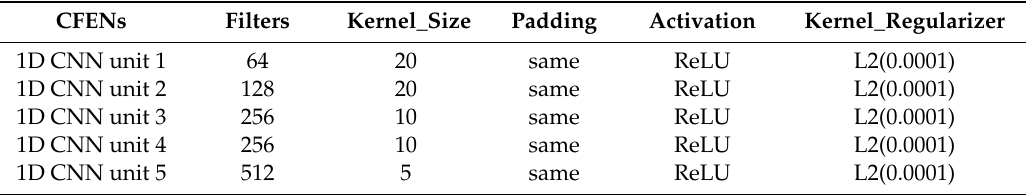
Table 1. Parameters of 1D CNNs.